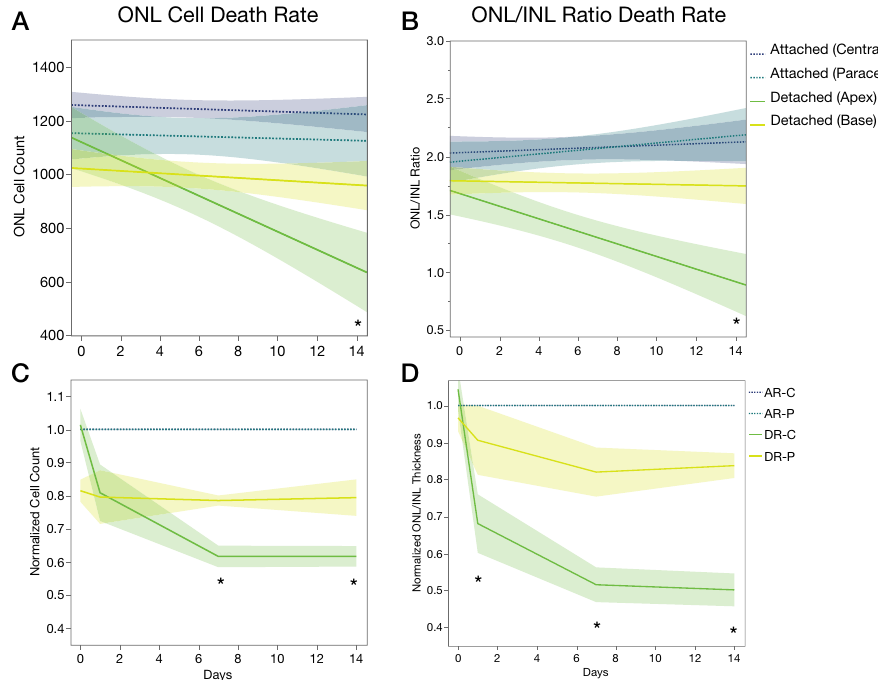
Figure 3. Cell death rate and normalized cell death following retinal detachment. ( A ) ONL cell death rate. ( B ) ONL/INL thickness ratio cell death rate. ( C ) Case 1: normalized ONL cell count. ( D ) Case 1: normalized ONL/ INL thickness ratio. * p < 0.05 (n =